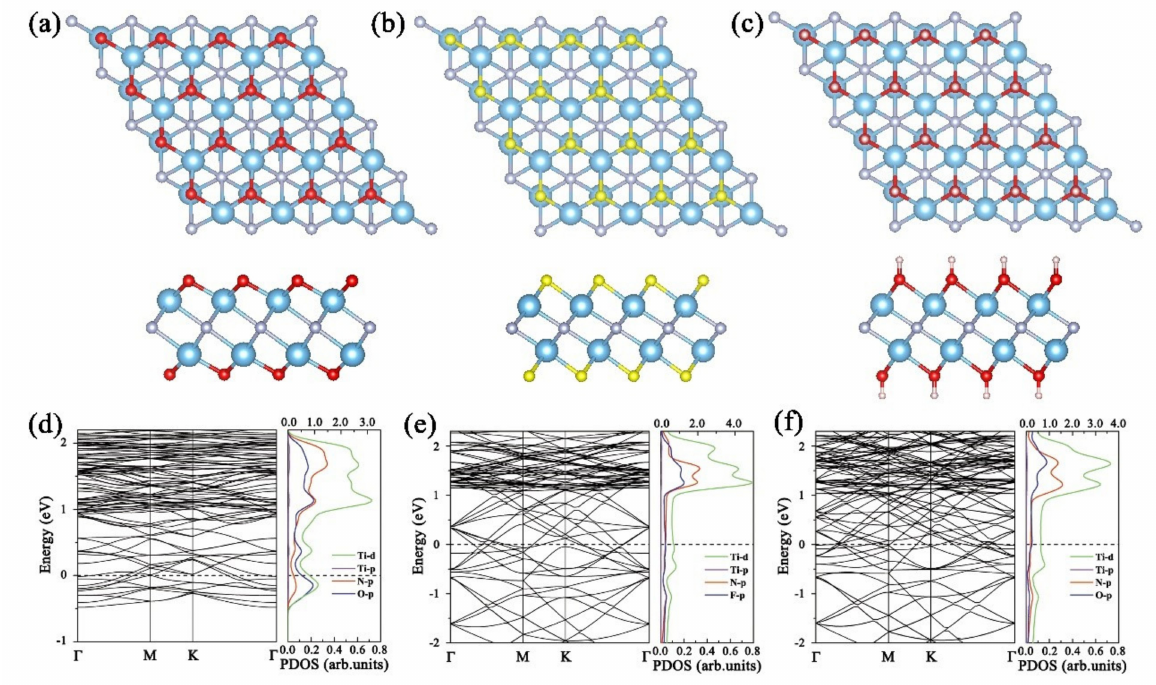
Figure 4. Top and side view of the optimized structures, band structures, and PDOS of ( a , d ) Ti 2 NO 2 , ( b , e ) Ti 2 NF 2 , and ( c , f ) Ti 2 N(OH) 2 monolayers (blue, silver, red, pink, and yellow balls represent Ti, N, O, H, and F atoms, respectively. Ti d -orbital uses top abscissa and other orbitals use bottom